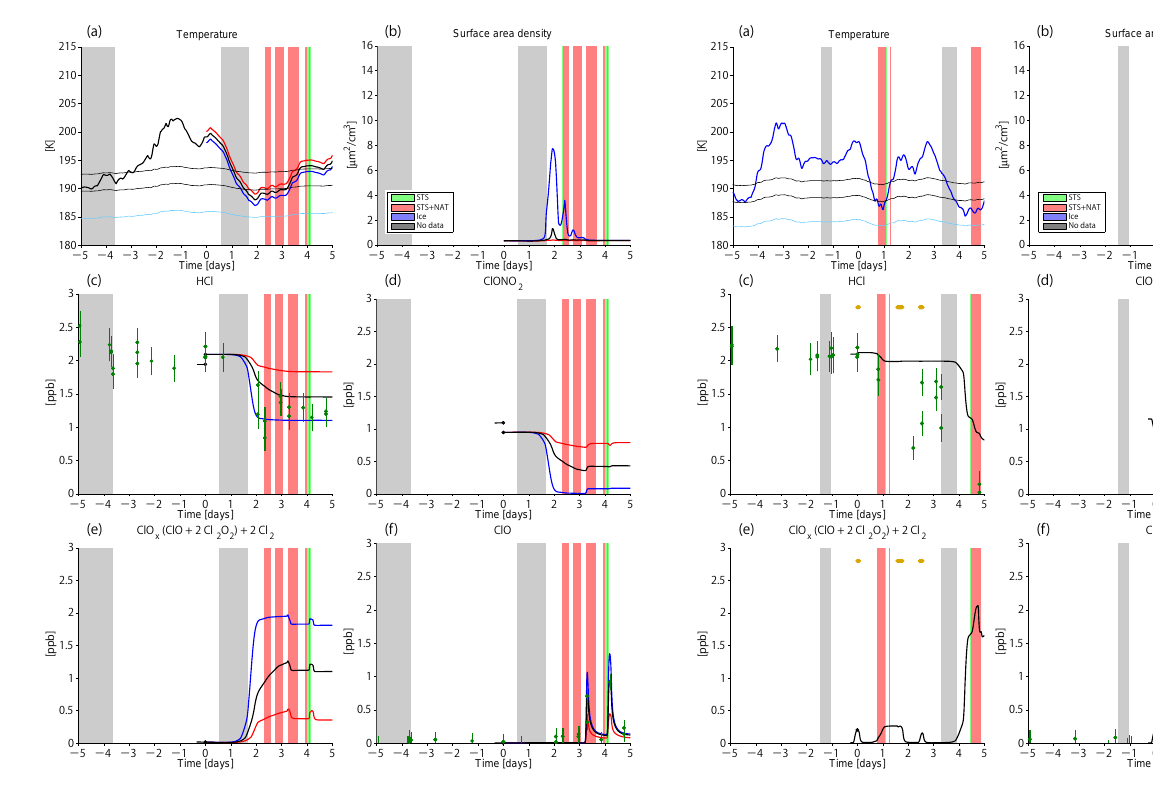
Figure 12. Temperature sensitivity runs for trajectory case no. 02. The black line shows the standard run, the red line a sensitivity run with temperature increased by 1K, and the blue line a sensitivity run with temperature decreased by 1K. MLS measurements and PSC types are the same as in Fig. 11.